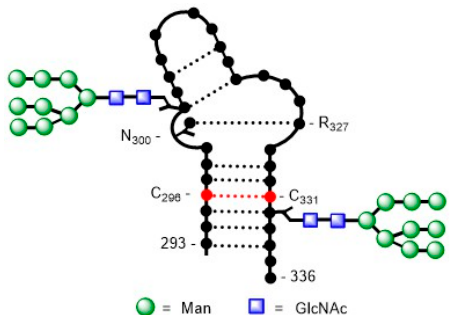
Figure 15. Secondary structure of Man 9 GlcNAc 2 V3 glycopeptide. Carbonyl or amide functions on the peptide backbone, hydrogen bonds and side chains are by nodes (.), dashed lines and ‘Y’, respectively.